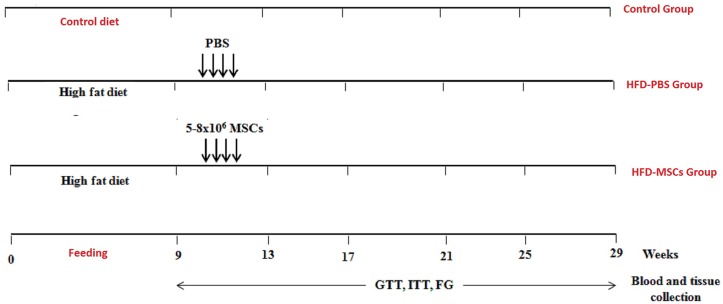
Experimental groups and study design.Eight weeks after high fat-diet or standard diet regimen (control group), mice received 4 weekly intraperitoneal (i.p) infusions of PBS (HFD-PBS group) or 5–8 x 106 BM-MSC (HFD-MSC group). Fasting glycemia (FG) was determined every week and glucose (GTT) and insulin (ITT) tolerance tests were performed in the 9th, 17th, 21st, 25th, and 29th week of the experimental period.